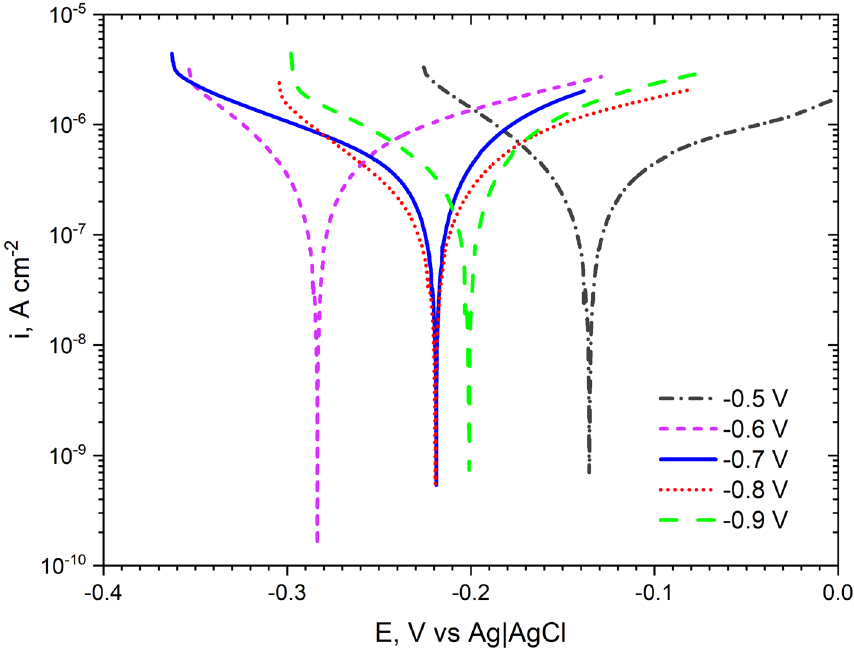
Figure 11. Potentiodynamic polarization curves recorded after 24 h of exposure in 0.05 mol dm −3 deaerated NaCl solution of Ni–Mo coatings.